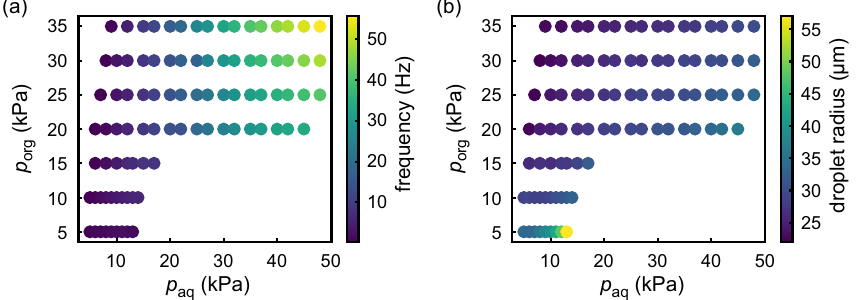
Figure 3. ( a ) Frequency of droplet generation as a function of the inlet gauge pressure for the organic solution (inlet 1) p org and that for the aqueous solution (inlet 2) p aq . Data points are plotted only in regions where the droplets were generated. ( b ) Radius of the generated droplet as a function of the inlet pressure for the organic solution (inlet 1) p org and that for the aqueous solution (inlet 2) p aq